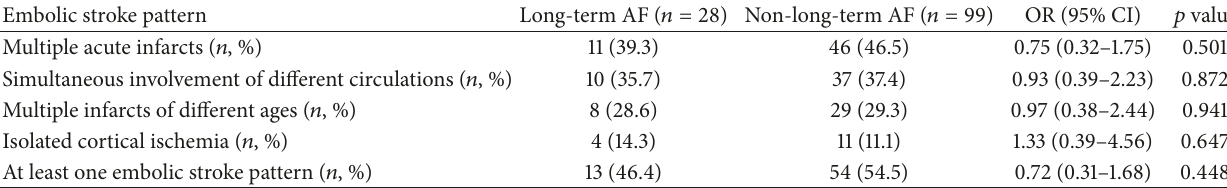
Table 4: Association between embolic stroke patterns and long-term diagnosis of atrial fibrillation (baseline ECG to 12-month follow-up) ( 𝑛 = 127